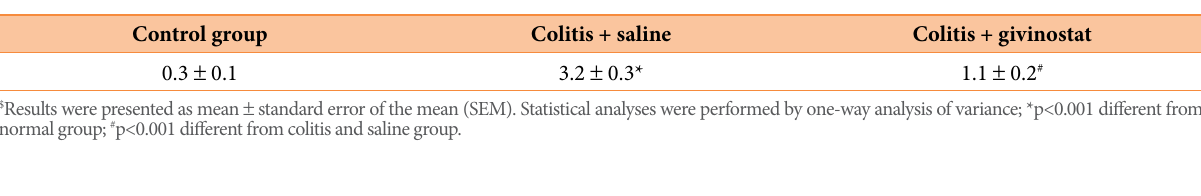
Table 2 - Histopathological scores of groups $